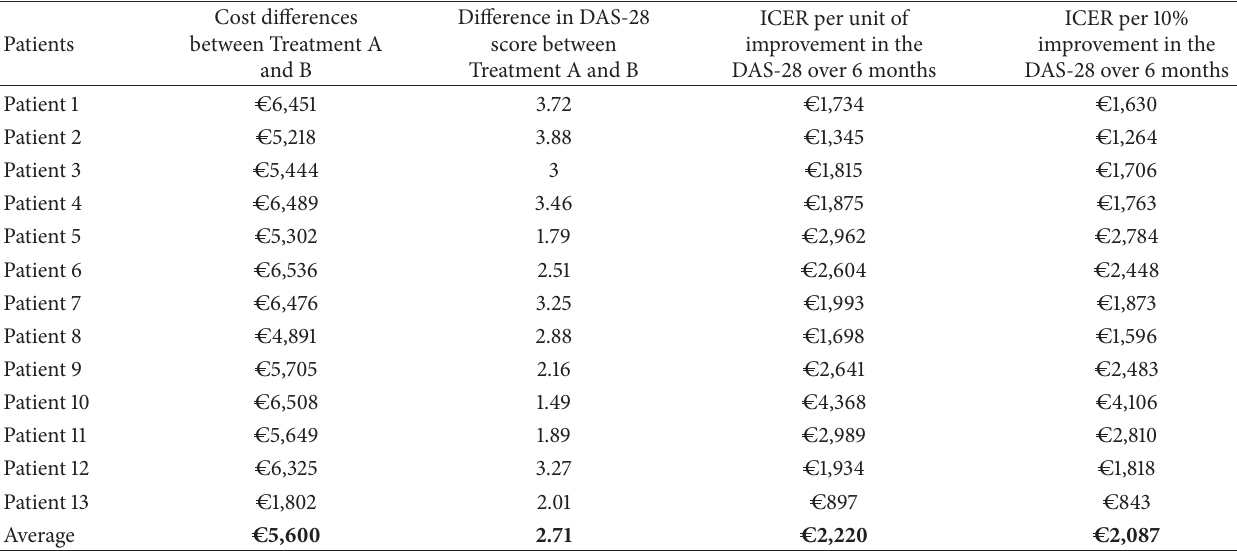
Table 4: Resulting ICERs in terms of improvement by the